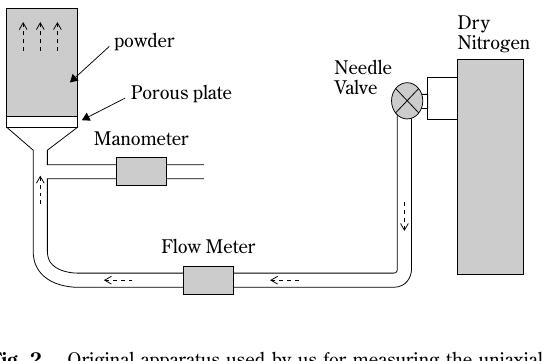
Pressure drop across a bed of toner (Canon CLC500 cyan) consolidated by a consolidation stress s c (cid:8) 70 Pa. Cross- sectional area of the bed 20.3 cm 2